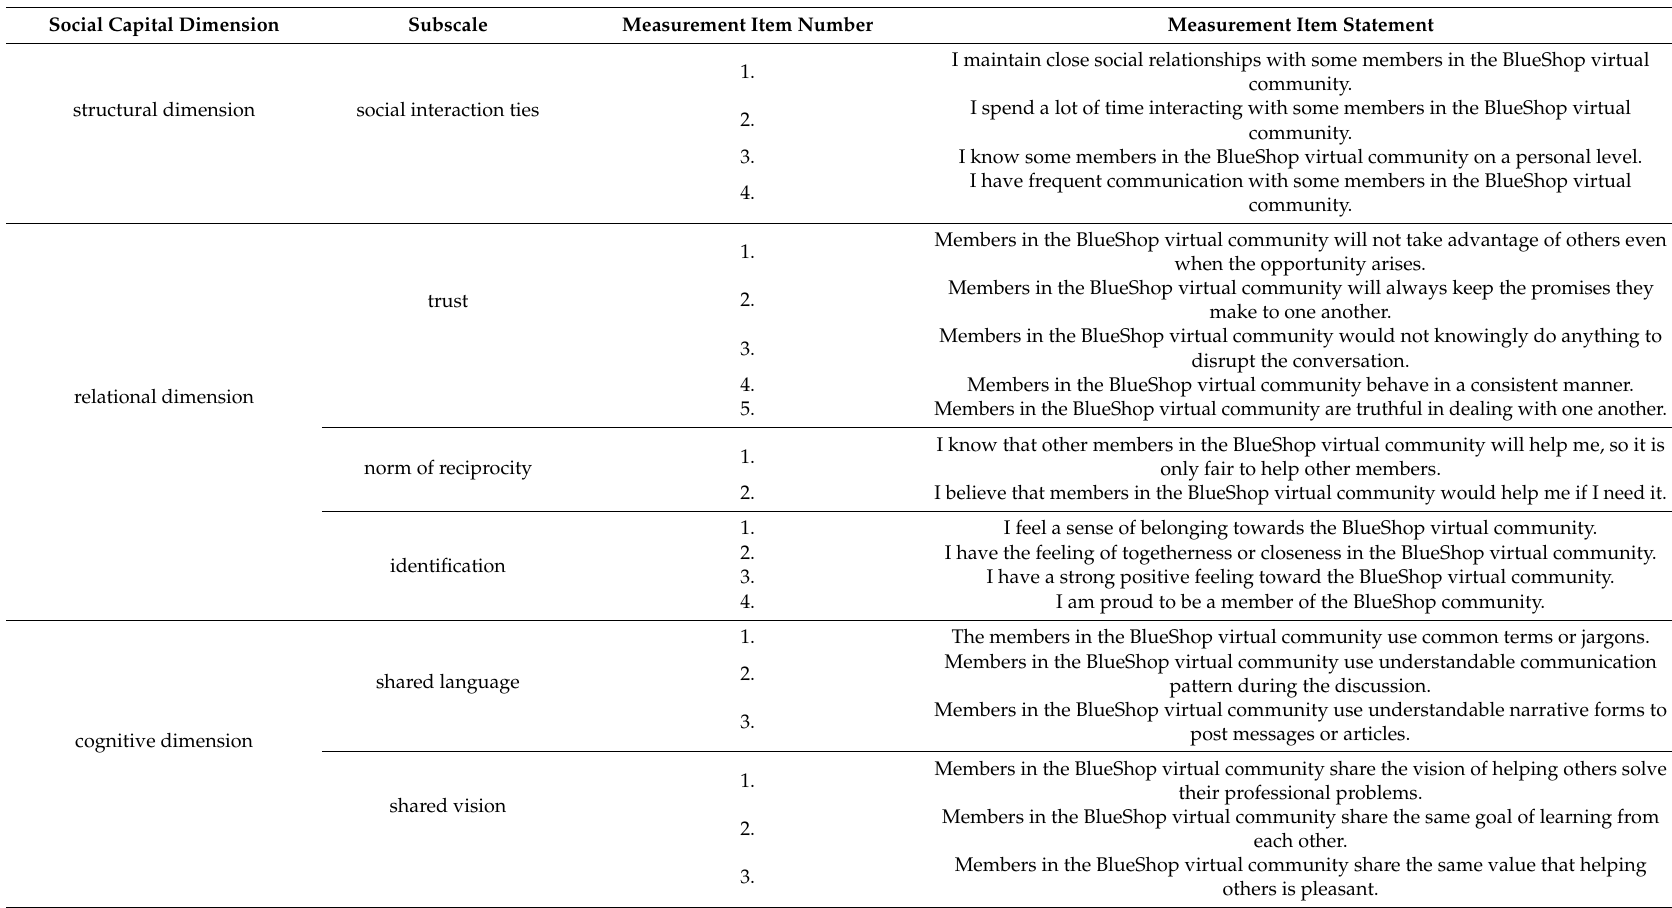
Table 2. Social capital dimensions, subscales and respective measurement items based on Chiu et al. (2006). Social Capital